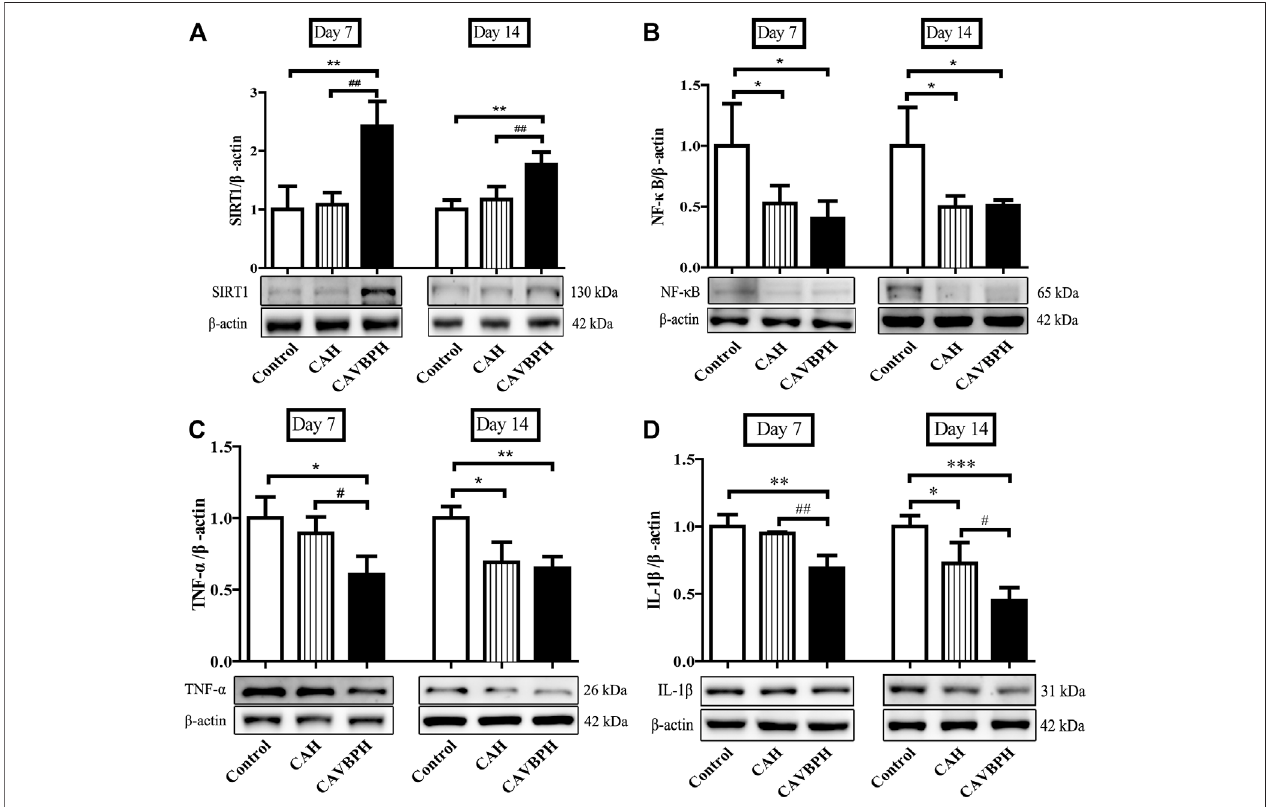
FIGURE7| Western blottinganalysisofproteins related totheSIRT1/NF- κ Bpathway. (A) Proteinbandsand quantitativeanalysisofSIRT1. (B) Protein bandsand quantitative analysis of NF- κ B. (C) Protein bands and quantitative analysis of TNF- α . (D) Protein bands and quantitative analysis of IL-1 β . * p < 0.05, ** p < 0.01, *** p < 0.001 vs . control group; # p < 0.05, ## p < 0.01, ### p < 0.001 vs . CAH group as statistically signi fi